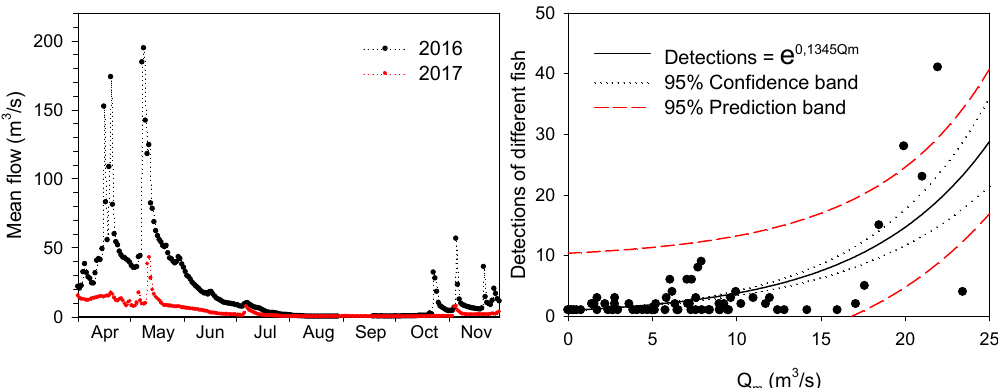
Figure 3. Daily mean river flow in 2016 and 2017 (left) and relationship between daily mean flow rate and top antenna detections (right). Flow was measured in a gauging station 5 km upstream from the dam.